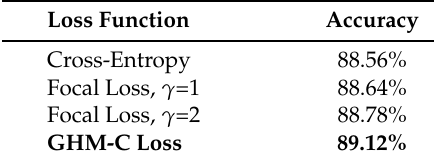
Table 3. Performance comparison of different loss functions.